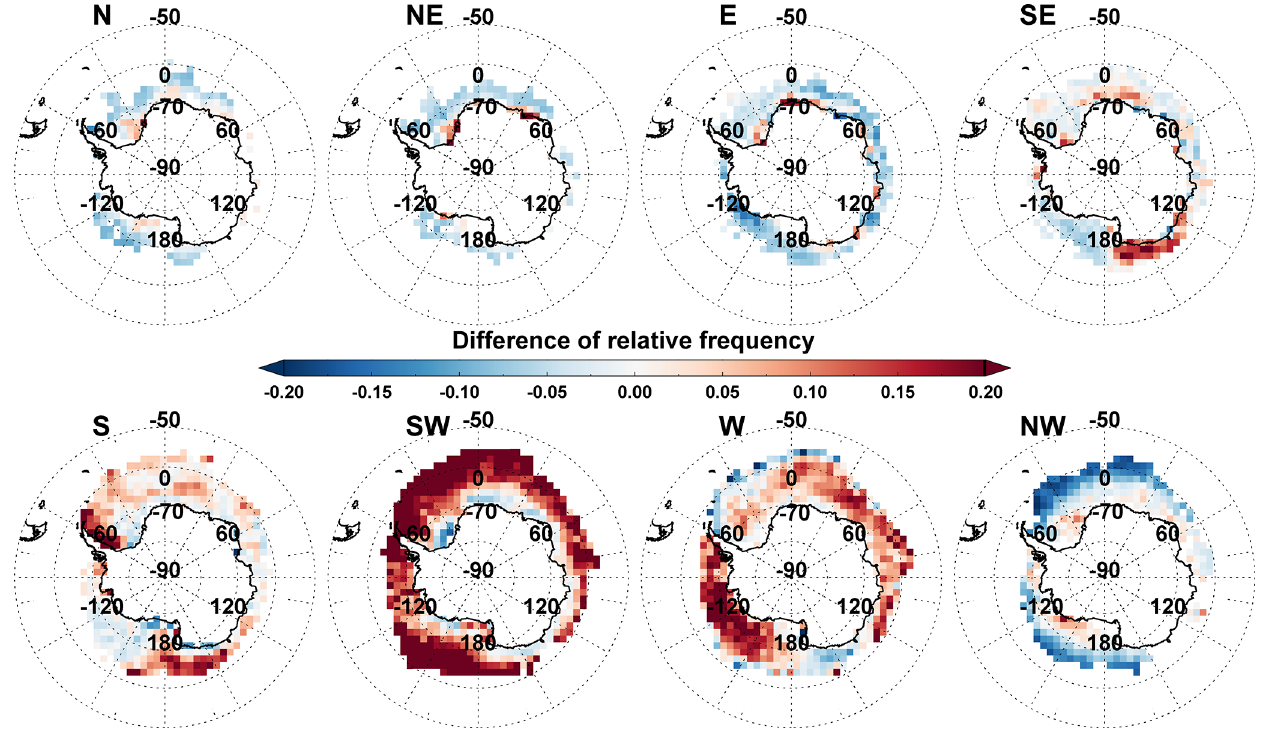
Figure 16. As Fig. 14 but for the Antarctic during spring (September to October in